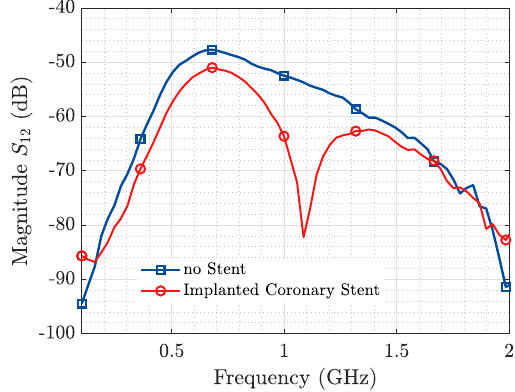
Figure 11. Coronary Stent Sensing. S 12